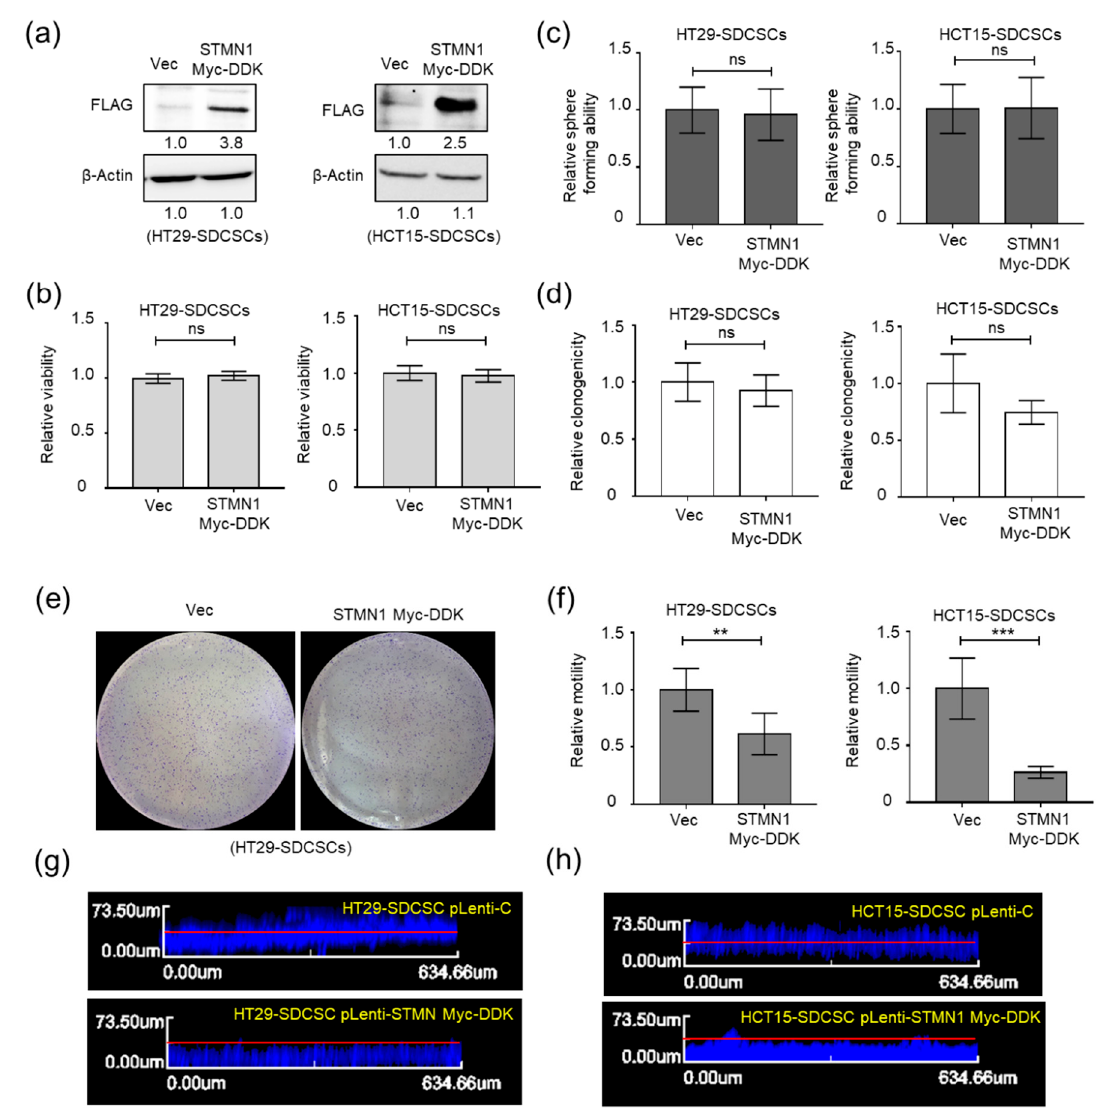
Figure 4. Restoration of STMN1 expression abolishes the migratory and invasive abilities of SDCSCs. ( a ) Western blots showing the expression of STMN1 in control SDCSCs (Vec) and SDCSCs ectopically expressing STMN1. An anti-FLAG antibody was used to detect the expression of exogenous STMN1 with a DKK-Myc tag. ( b ) Relative viability of cells as assessed by an MTT assay. ns, nonsignificant. ( c ) The sphere-forming capacity of control SDCSCs (Vec) and STMN-expressing SDCSCs (STMN1 DKK-Myc). ns, nonsignificant. ( d ) The colony formation of control SDCSCs (Vec) and STMN-expressing SDCSCs (STMN1 DKK-Myc). ns, nonsignificant. ( e ) Representative images showing the colonies generated. ( f ) Histograms showing the relative transwell migration ability of cells. ( g , h ) Representative images of vertical invasion of vector control HT29-SDCSCs (pLenti-C) and STMN-expressing SDCSCs (pLenti-STMN1 Myc-DDK). Data in bar charts are expressed as the mean ± SD values. ** p < 0.01; *** p < 0.001 (Student’s t -test). In an attempt to verify the participation of the miR-210-STMN1 axis in mediating